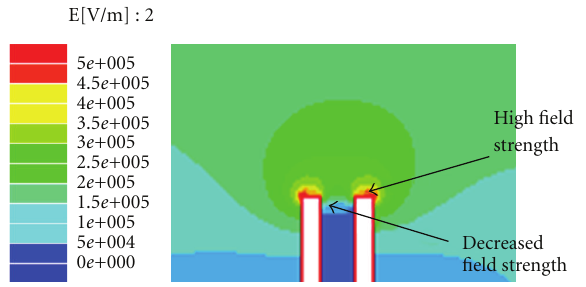
Figure 14: Enlargement of Figure 13.